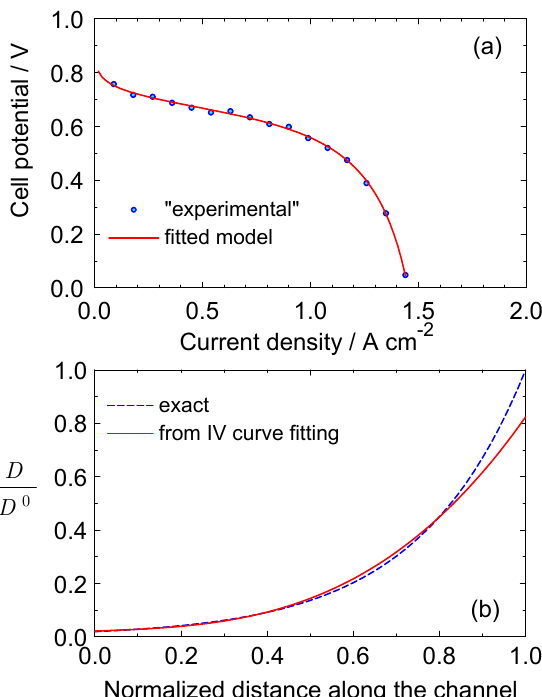
Figure 4. ( a ) Points: perturbed data from the polarization curve in Figure 2a (solid red line). Solid line: the results of the fitting of Equation (16) with model function Equation (22) to the data; ( b ) the exact and resulting from polarization curve fitting shapes of the oxygen diffusion coefficient along ˜ z .